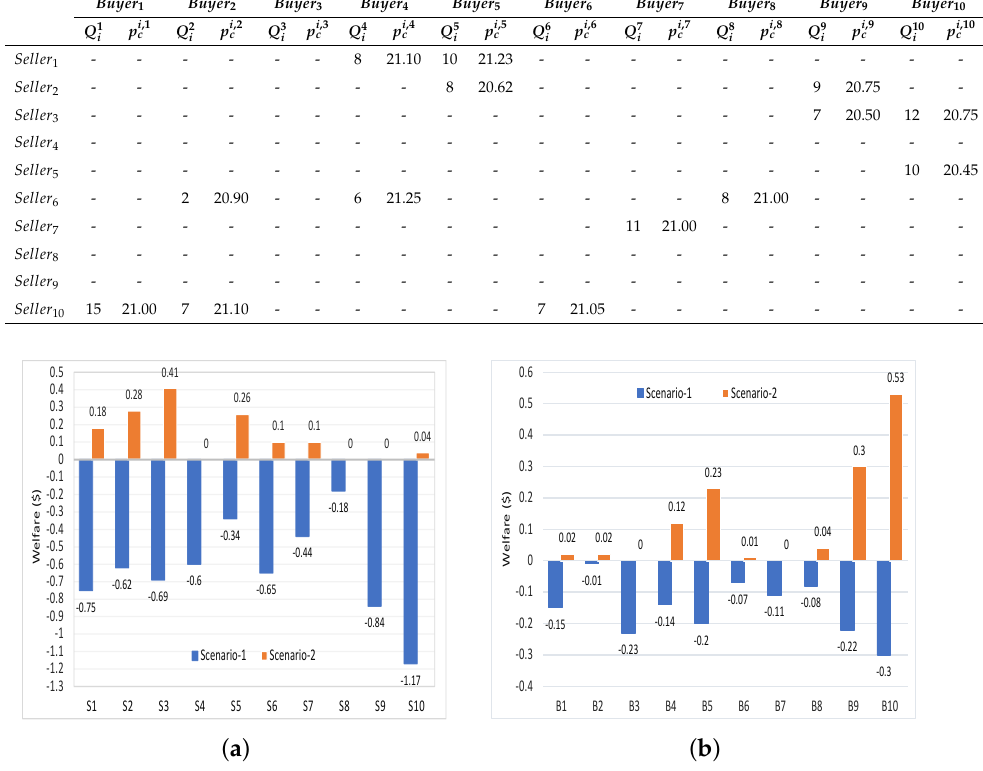
Figure 4. 2 Welfare values of scenario-1 and scenario-2. ( a ) Welfares of energy sellers; ( b ) Welfares of energy